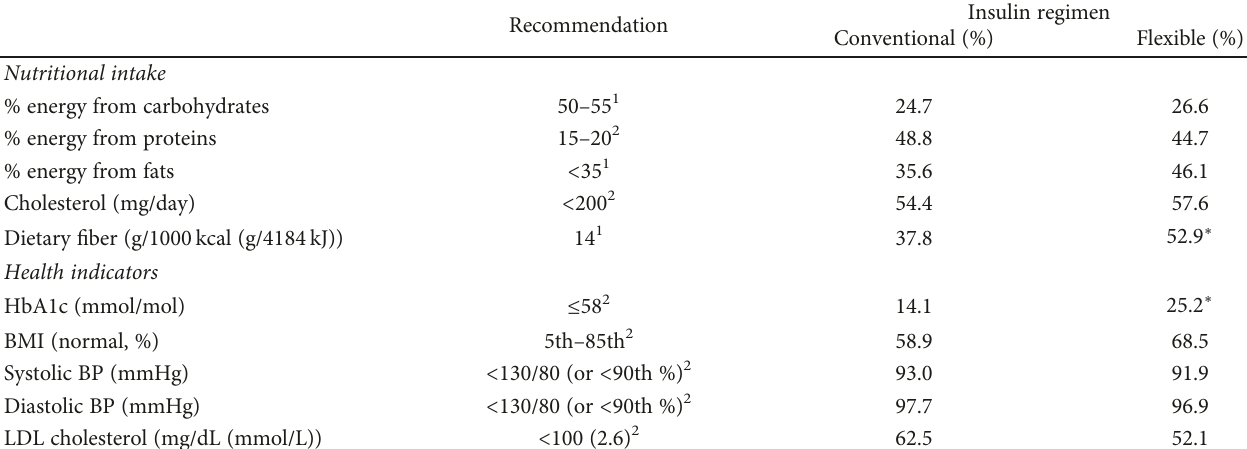
Table 2: Frequency of participants meeting nutritional